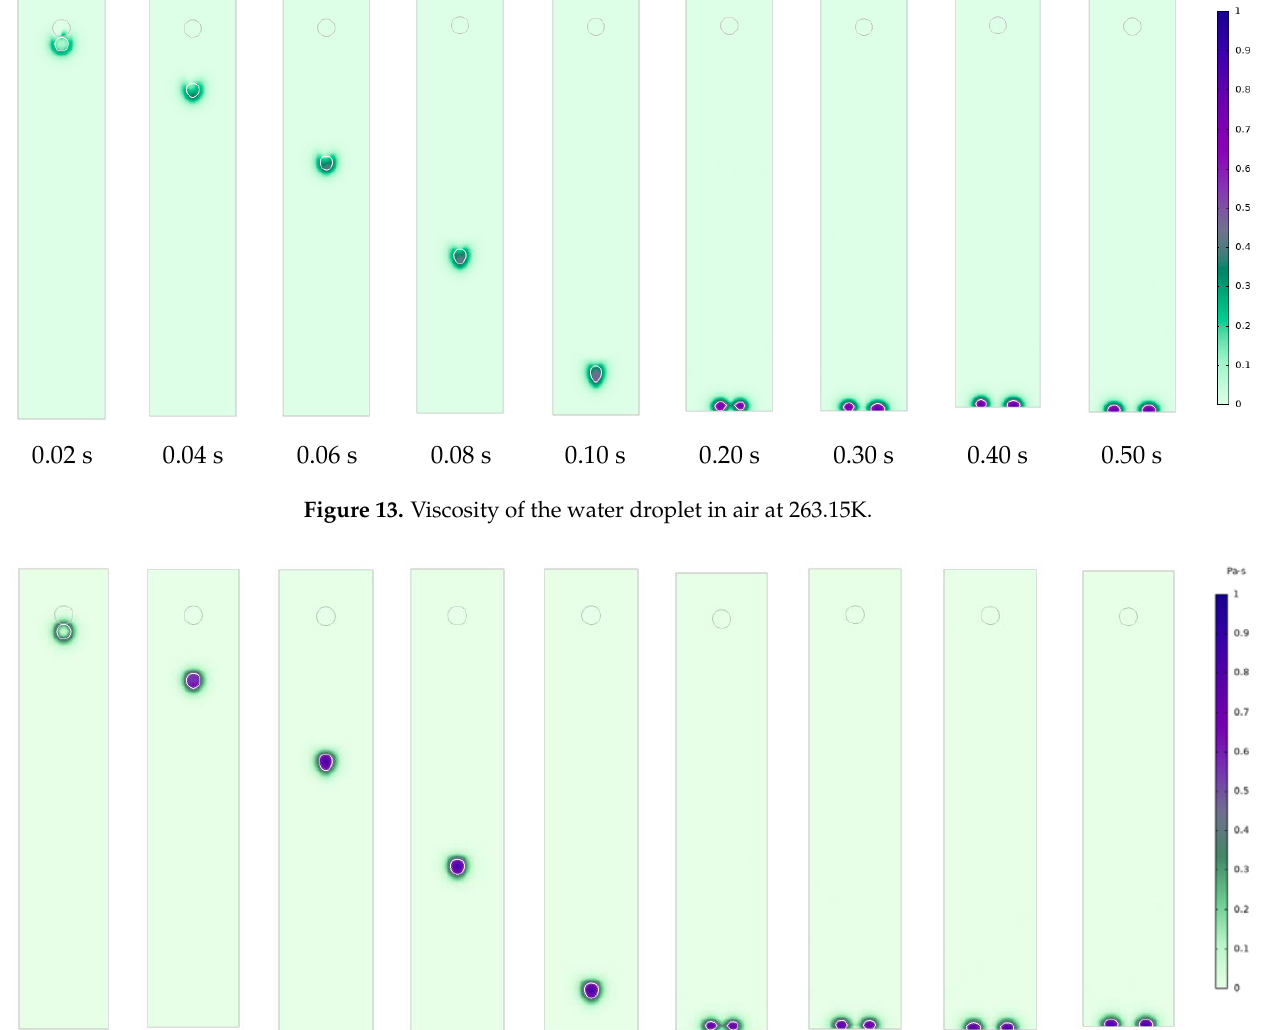
Figure 12. Temperature distribution of a free-falling water droplet in air at 243.15 K.